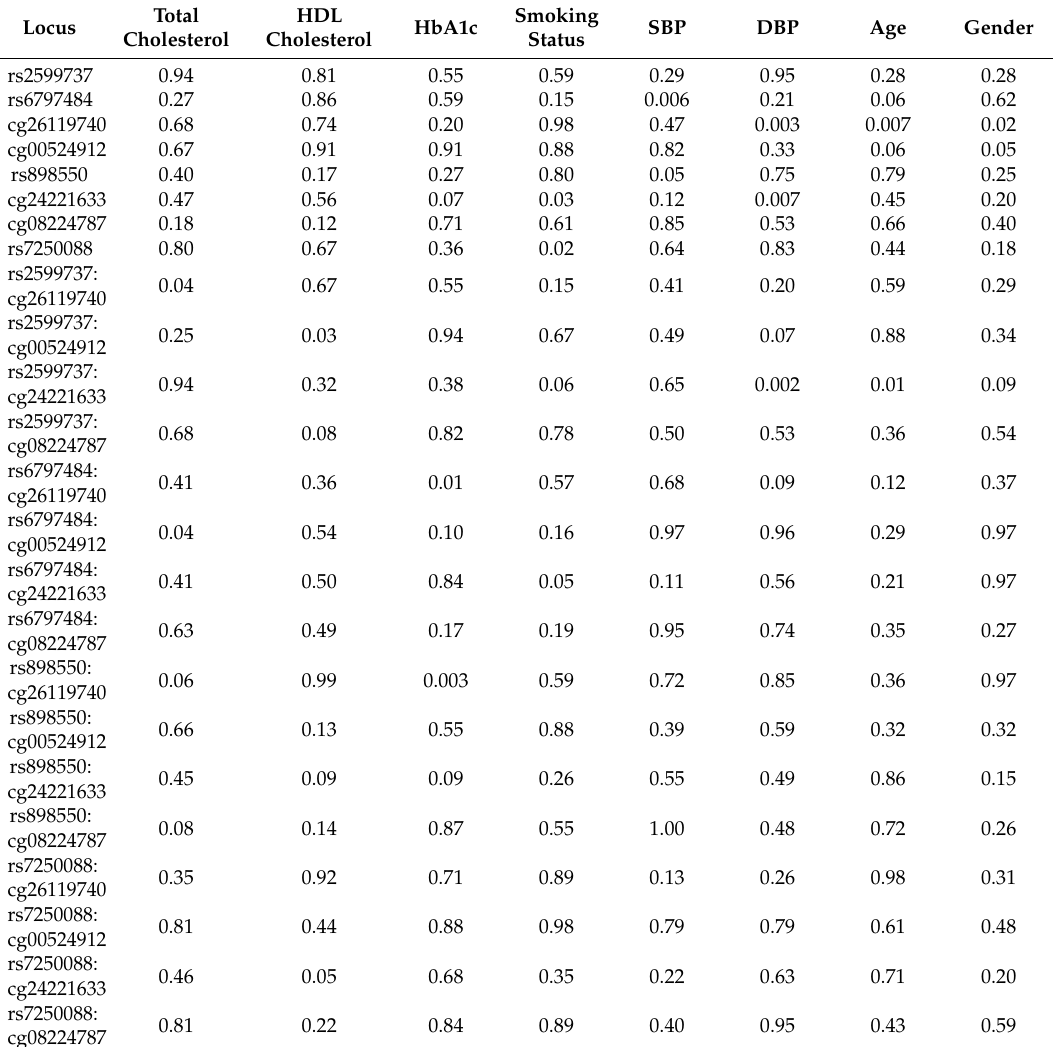
Table 4. The nominal p -value of the main and interaction terms of genetic and epigenetic biosignatures to conventional CHD risk